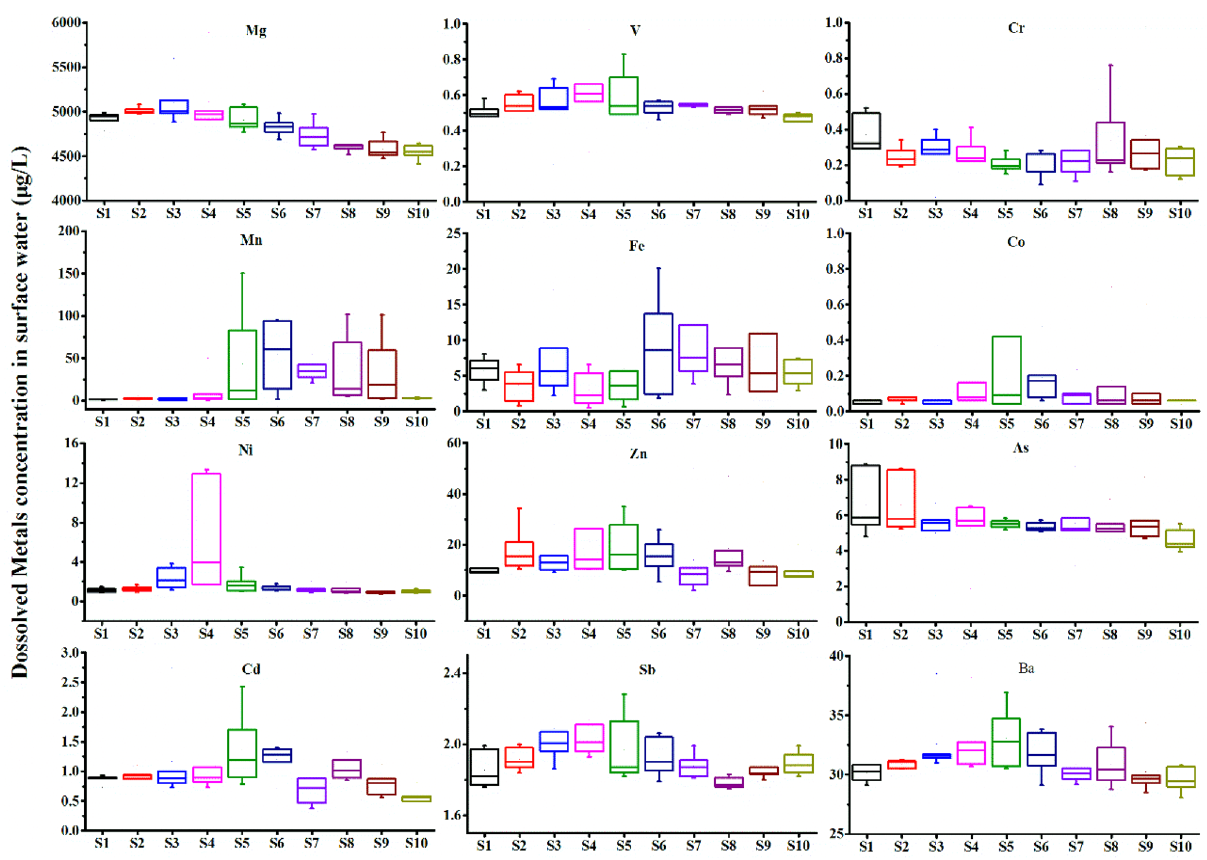
Figure 2. Spatial distribution of metals in surface